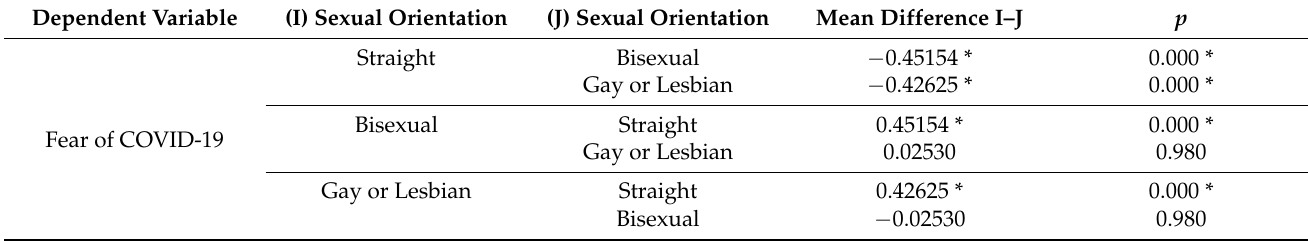
Table 7. Results for the Negative Impact of COVID-19 by comparison groups (Sexual Orientation). Dependent Variable